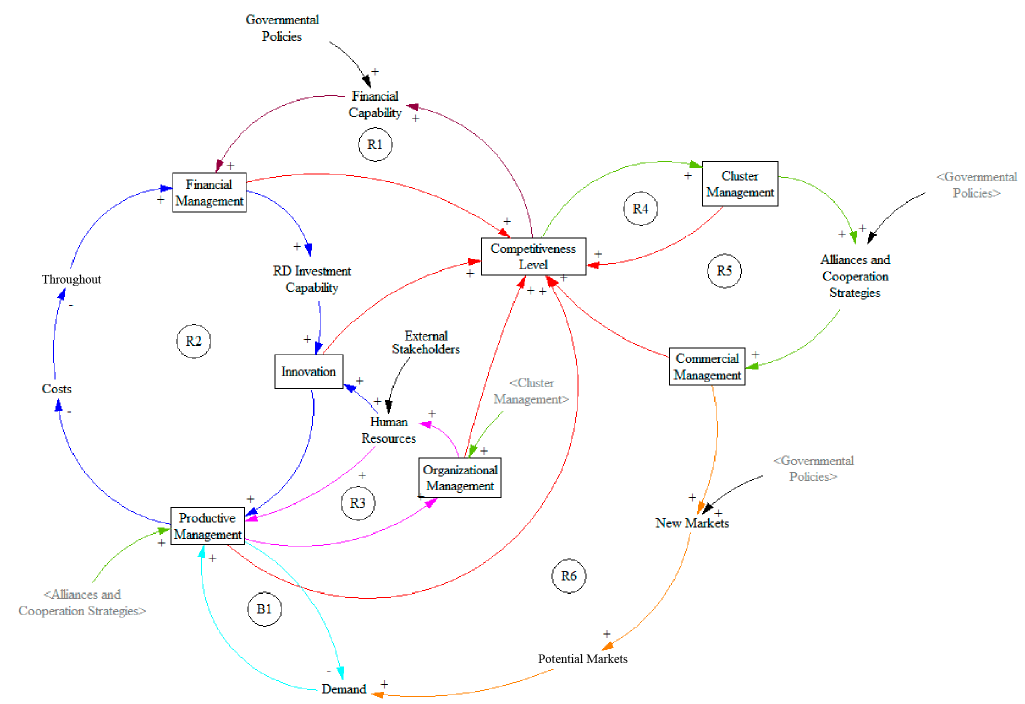
Figure 3. Aggregate Causal Diagram—Cluster Competitiveness.